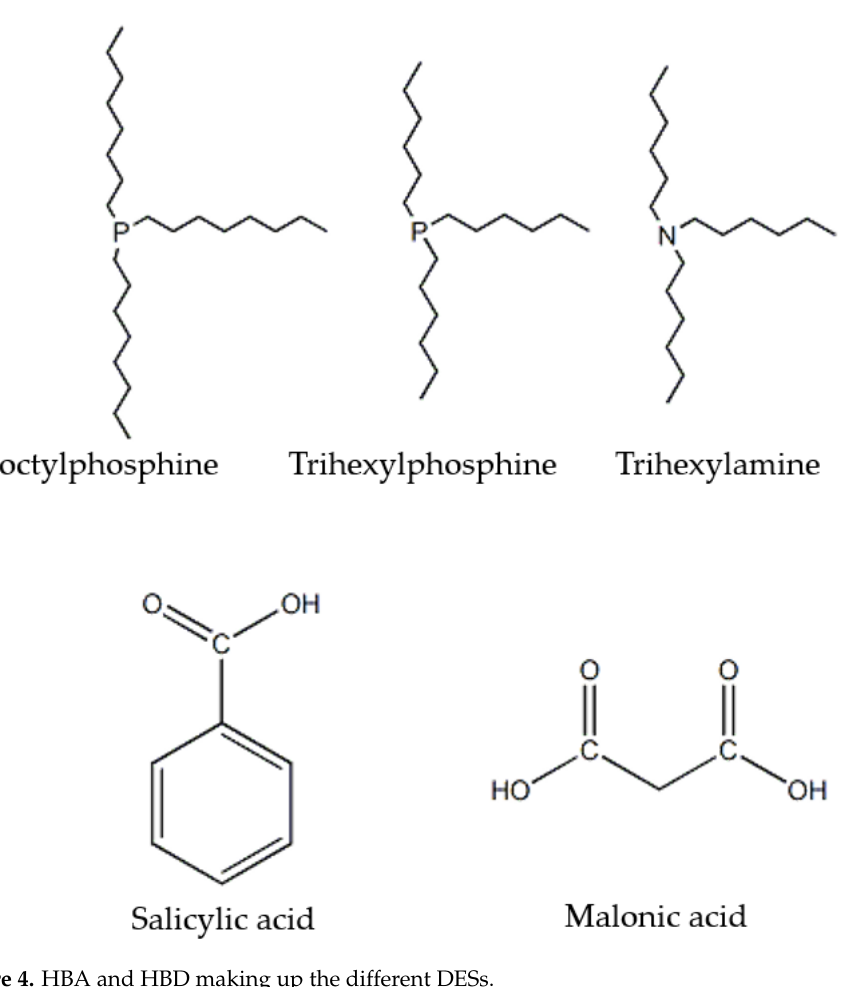
Figure 3. The prepared DESs.